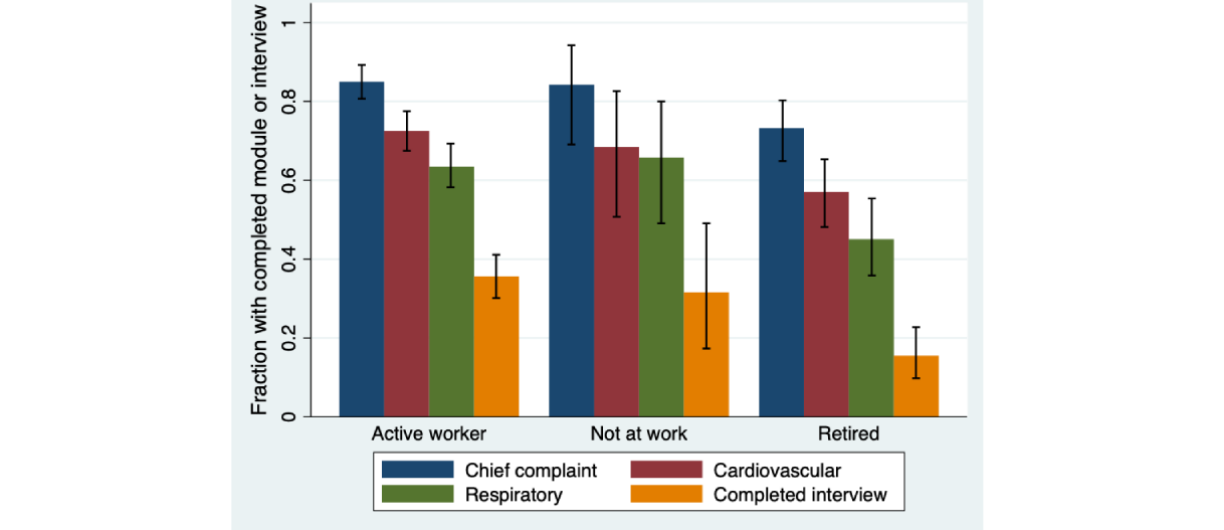
Figure 5. Fractions (with 95% CIs) of completed key modules and completed interviews, stratified by occupational status (320 active workers, 38 not at work, 142 retired). Active worker: employed or student; not at work: unemployed or on sick